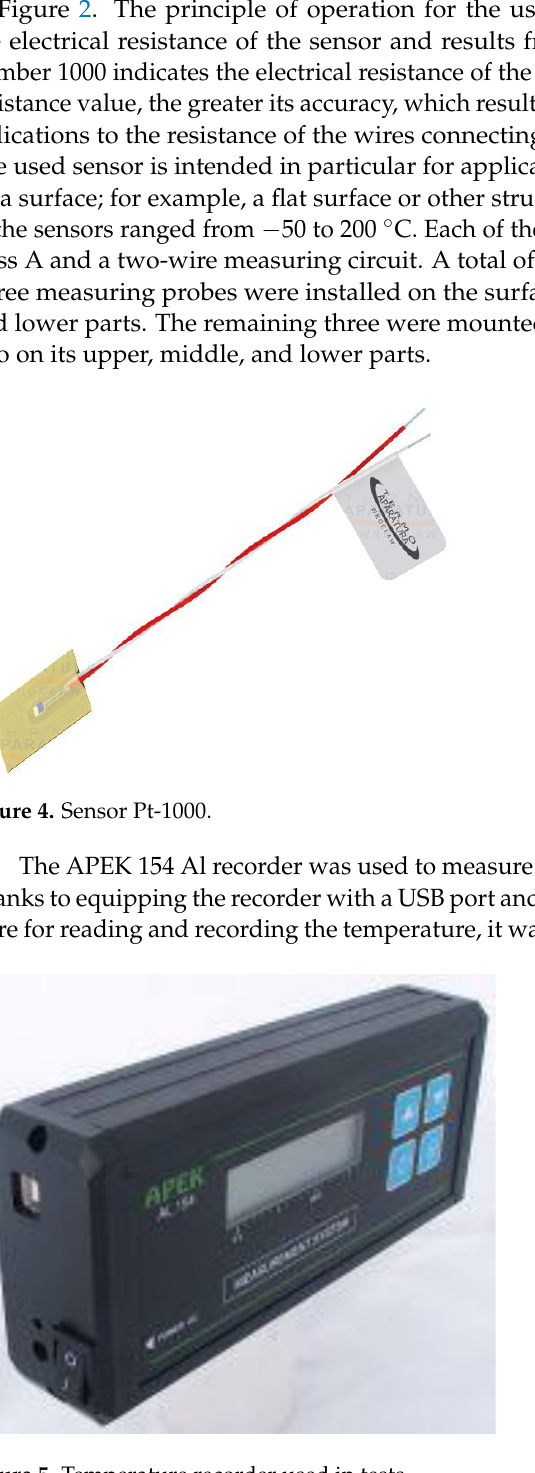
Figure 5. Temperature recorder used in tests.